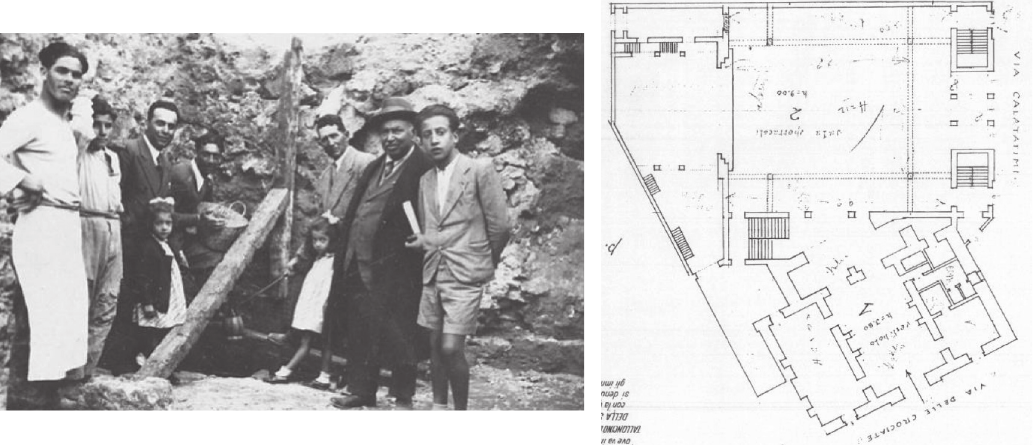
Figure 3: Historical photos: principals (a) and original structure design (b).